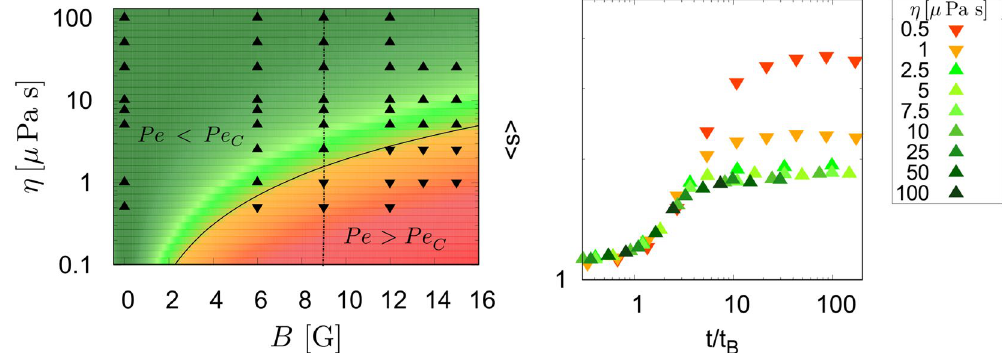
Figure 3. Left: global efficiency of the time scaling for all simulations. Upwards triangles are the simulations whose curves collapse with others with the same magnetic field. Downwards triangles are the simulations which don’t collapse. The black curve represents the transition Pe = Pe C , and the colour gradient is related to the difference of local Peclet number and its critical value Pe − Pe C . Right: a graphic showing the curves obtained for the simulations performed with a magnetic field B = 9 G. Those curves then correspond to the points on the dot-dashed line in the left graphic. The red and orange curves are not collapsing with the others and correspond to cases Pe > Pe